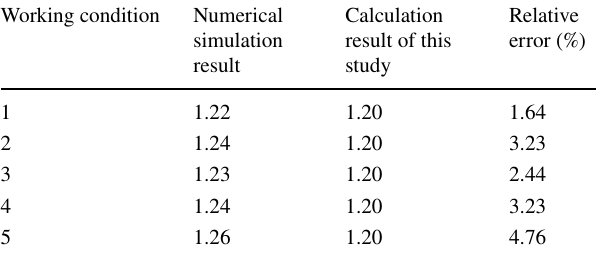
Table 6 Stability calculation result of inner dump Working condition Numerical